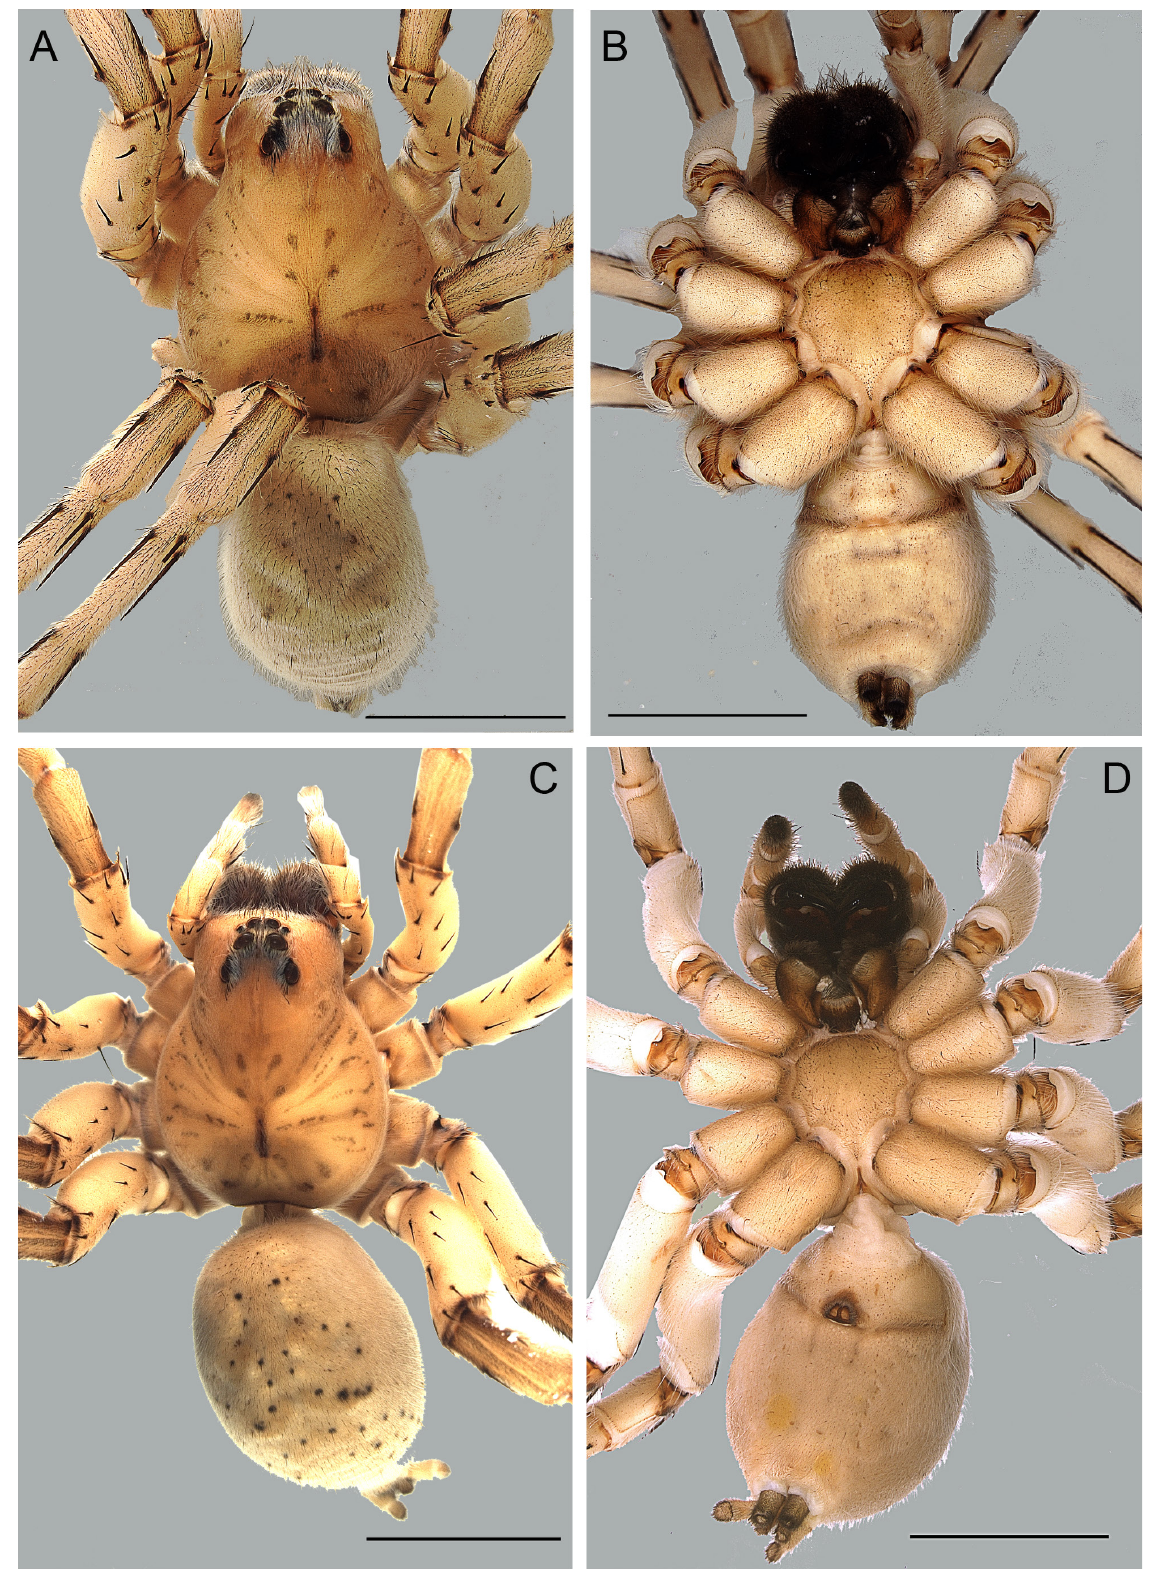
Fig. 4. Ocyale ghost Jocque M. & Jocqué R. sp. nov. A–B . Holotype, ♂. A . Dorsal habitus. B . Ventral habitus. C–D . Paratype, ♀ (MRAC 245338). C . Dorsal habitus. D . Ventral habitus. Scale bars = 0.5